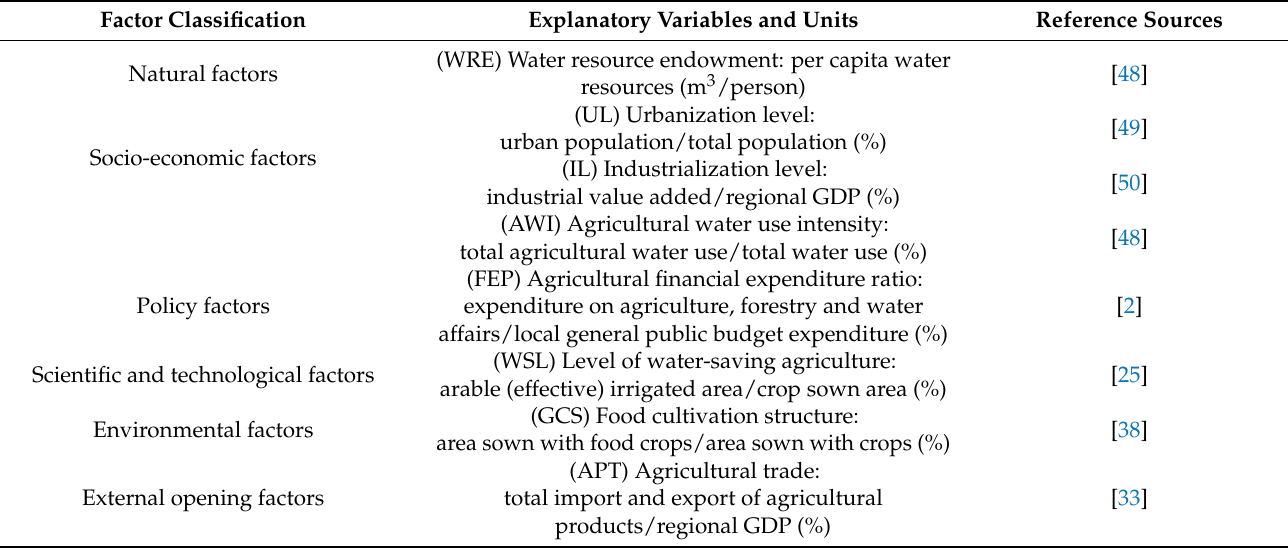
Table 2. Influencing factors of the green efficiency of agricultural water use.